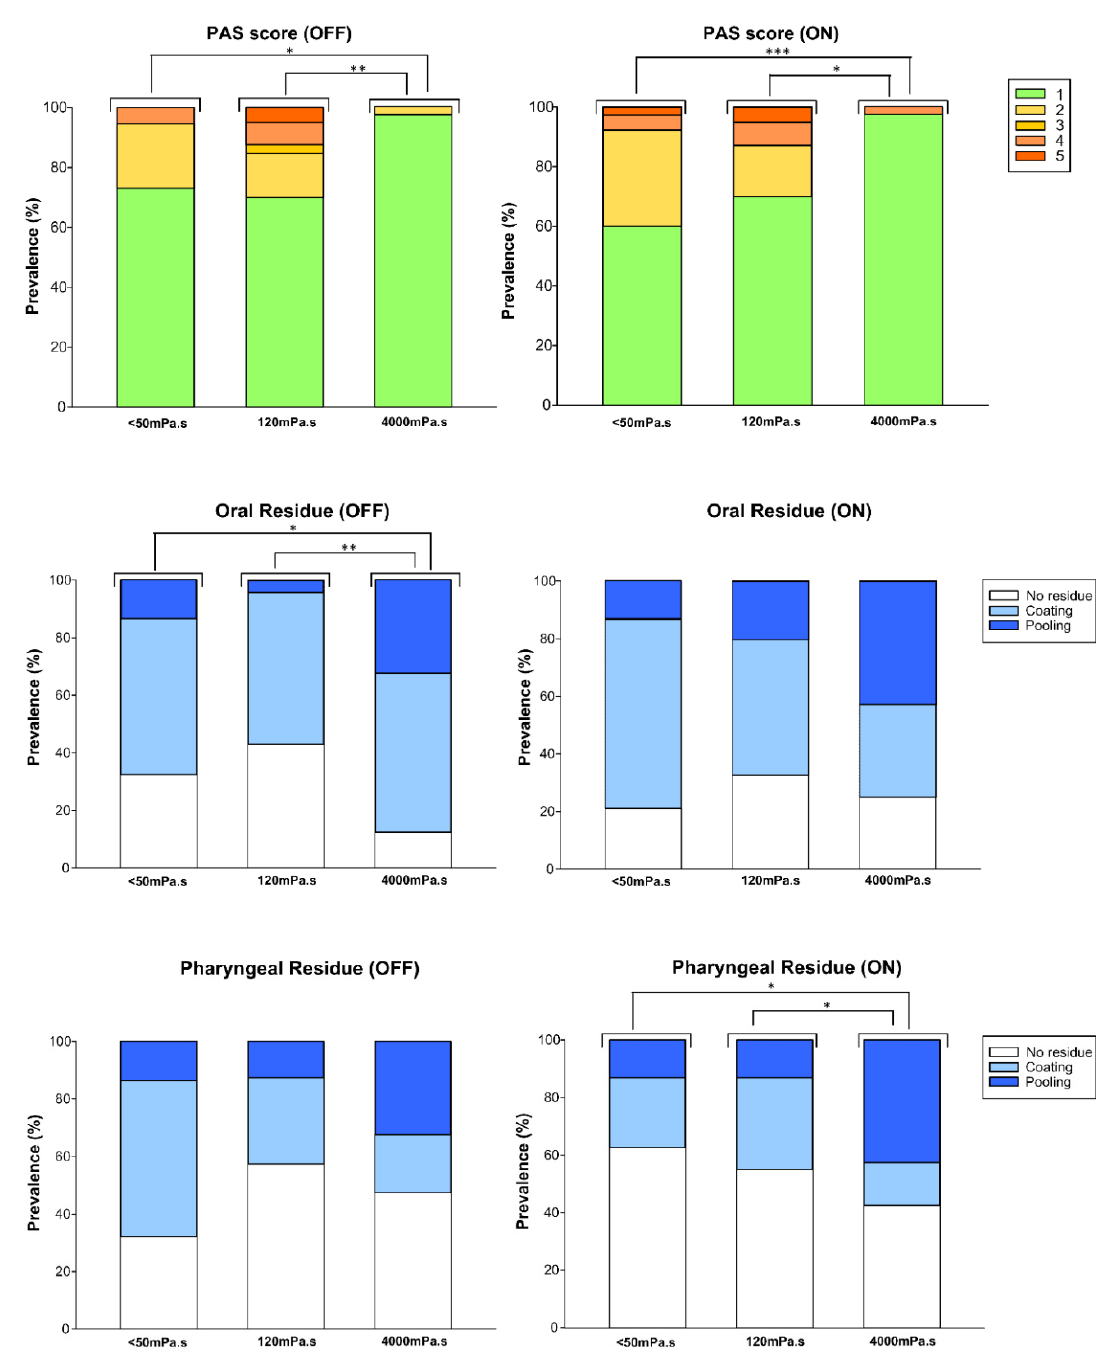
Figure 4. Prevalence of safe swallowing and penetration (PAS score) and oral and pharyngeal residues for three bolus viscosities (<50 mPa·s, 120 mPa·s, and 4000 mPa·s) in the OFF and ON states. OFF p -values * <0.05 and ** <0.01; ON p -values * <0.05 and *** <0.001.